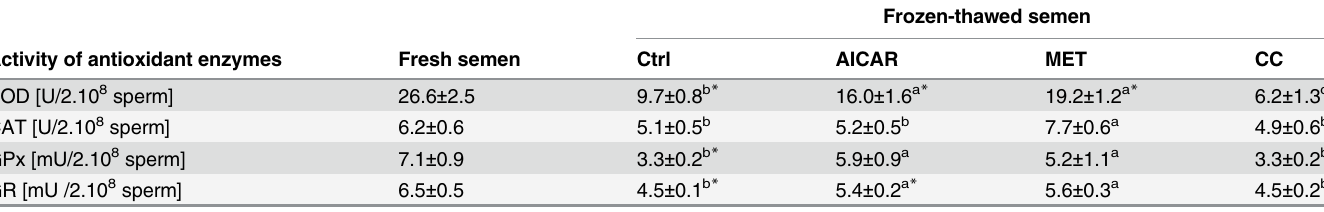
Different superscripts in lines indicate signi fi cant differences between control (Ctrl) and treatments in frozen-thawed semen ( a,b,c , P < 0.05). Asterisks in lines indicate statistically signi fi cant differences between fresh and frozen-thawed semen ( * , P < 0.05).